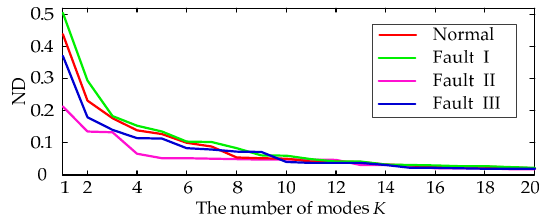
Figure 9. The NDs between the reconstructed signals and the measured signals with different K .